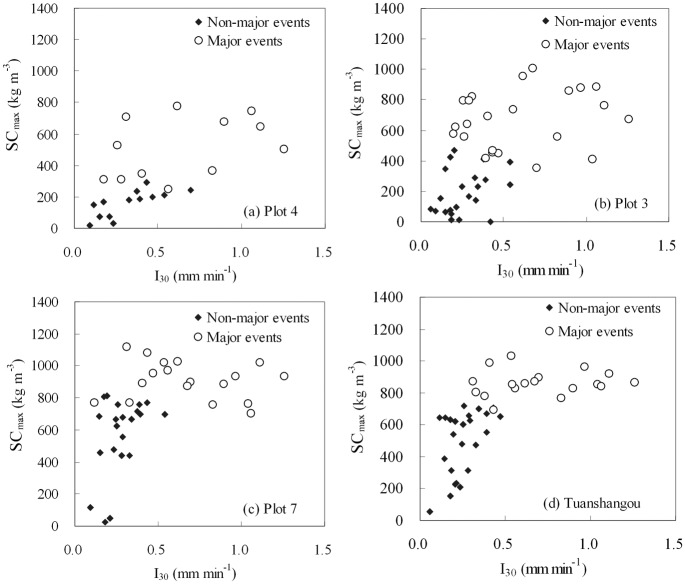
The relationship between I
30 and SC
max for the Tuanshangou station (#3) and three experimental runoff plots within it.